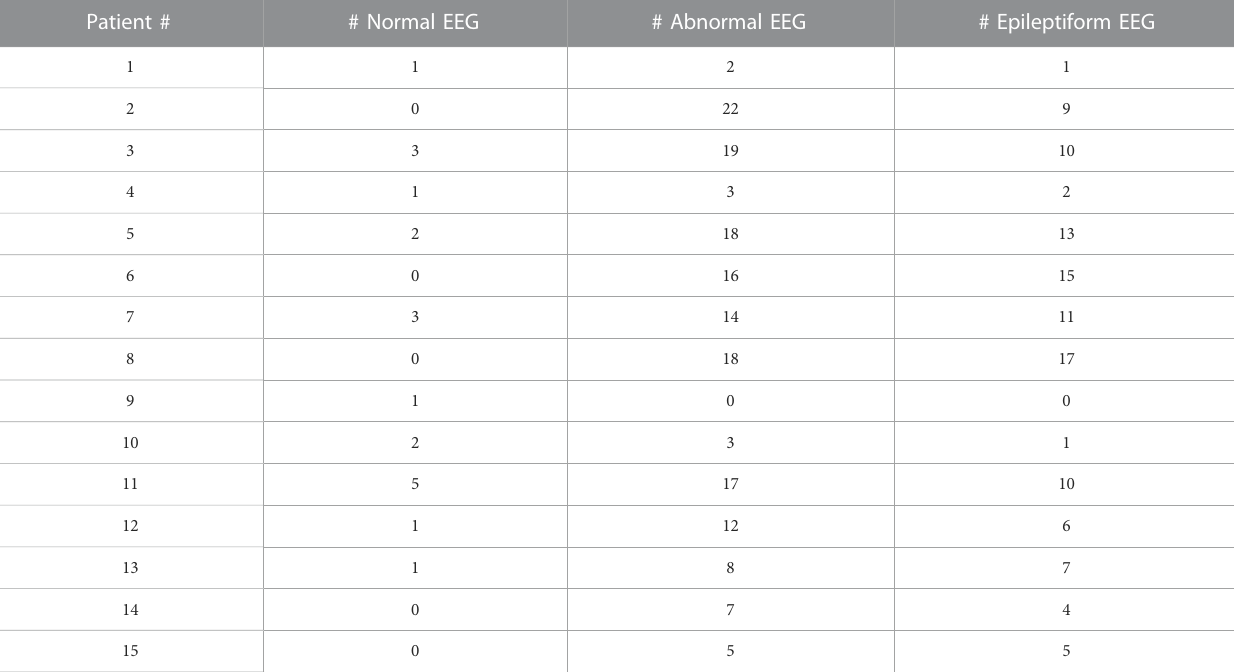
TABLE 4 EEG report summary. Total number of normal, abnormal, and epileptiform EEGs are listed for each